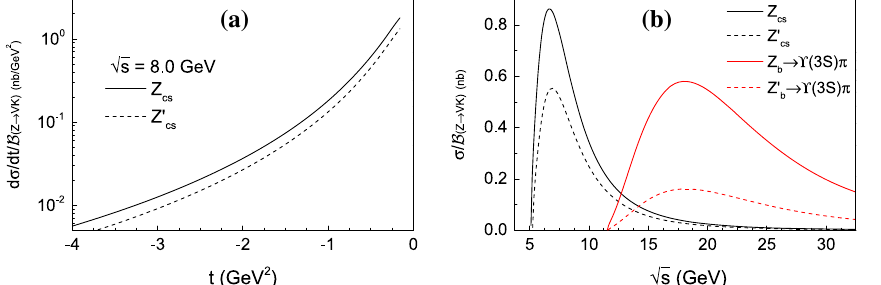
(cid:3) ) with considering ϒ( 3 S ) only in the VMD model. It shall be noted that cs . → J /ψ K ) are set to be 1.0 while realistic B ( Z (cid:3) B ( Z (cid:3) cs been included as shown in Table 1